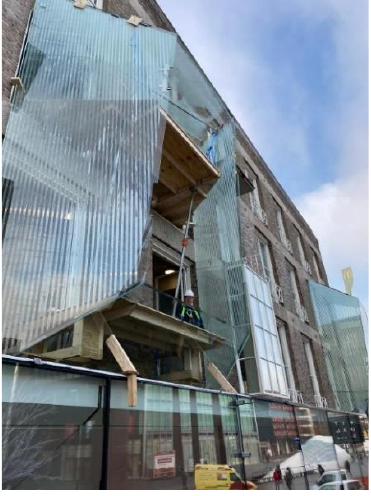
Fig. 15 installation of side panels. Fig. 16 installation of top panel.